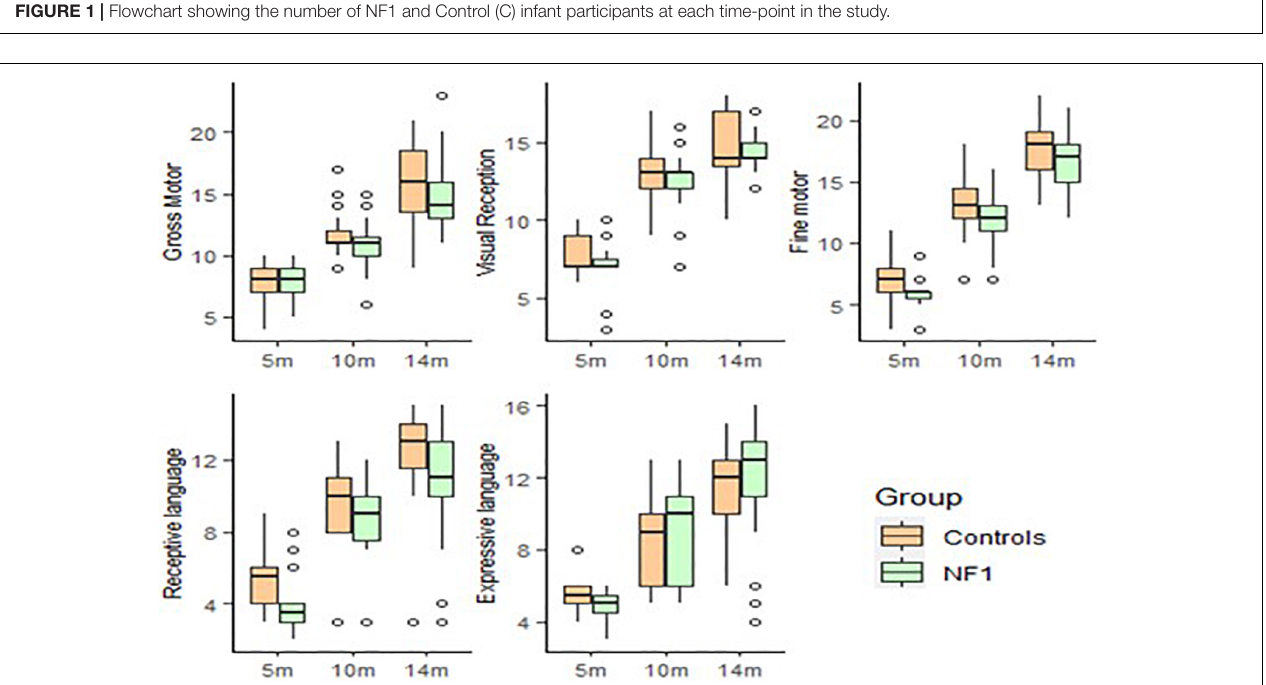
FIGURE 2 | Box-whisker plots of the NF1 and control groups on the Mullen Scale of Early